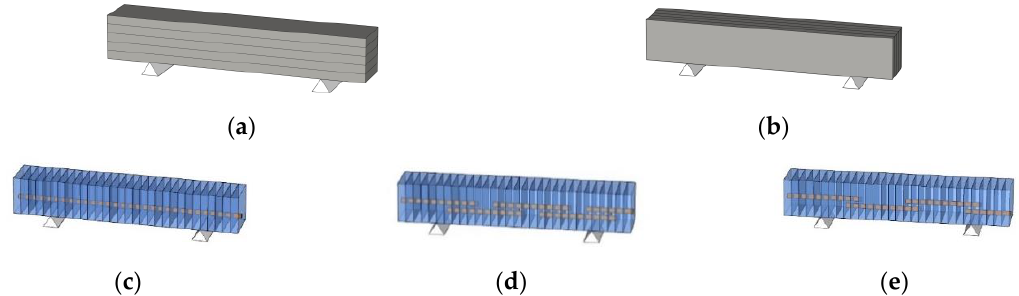
Figure 13. Flexural tensile strength tests under different loading directions. ( a ) Direction I (S1); ( b ) Direction II (S1); ( c ) Direction III (S2–300); ( d ) Direction III (S3–40); ( e ) Direction III (S4–20).